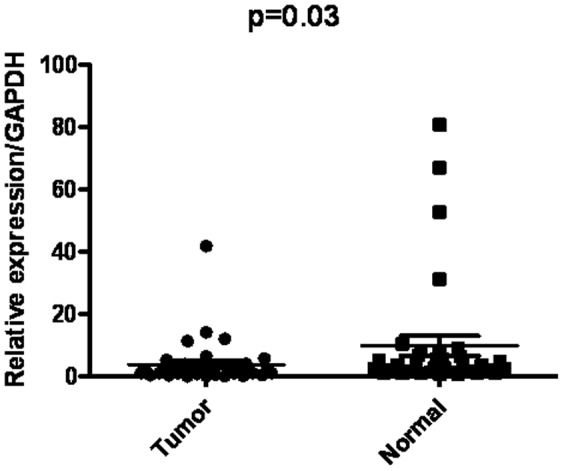
Real-time quantitative RT-PCR analysis of FOXO3a expression in gastric cancer surgical specimens.The relative mRNA expression of FOXO3a was significantly lower in 24 of 35 (68.6%) gastric cancer tissues compared with the corresponding non-tumorous tissues. (FOXO3a/GAPDH, n = 35, p = 0.03).